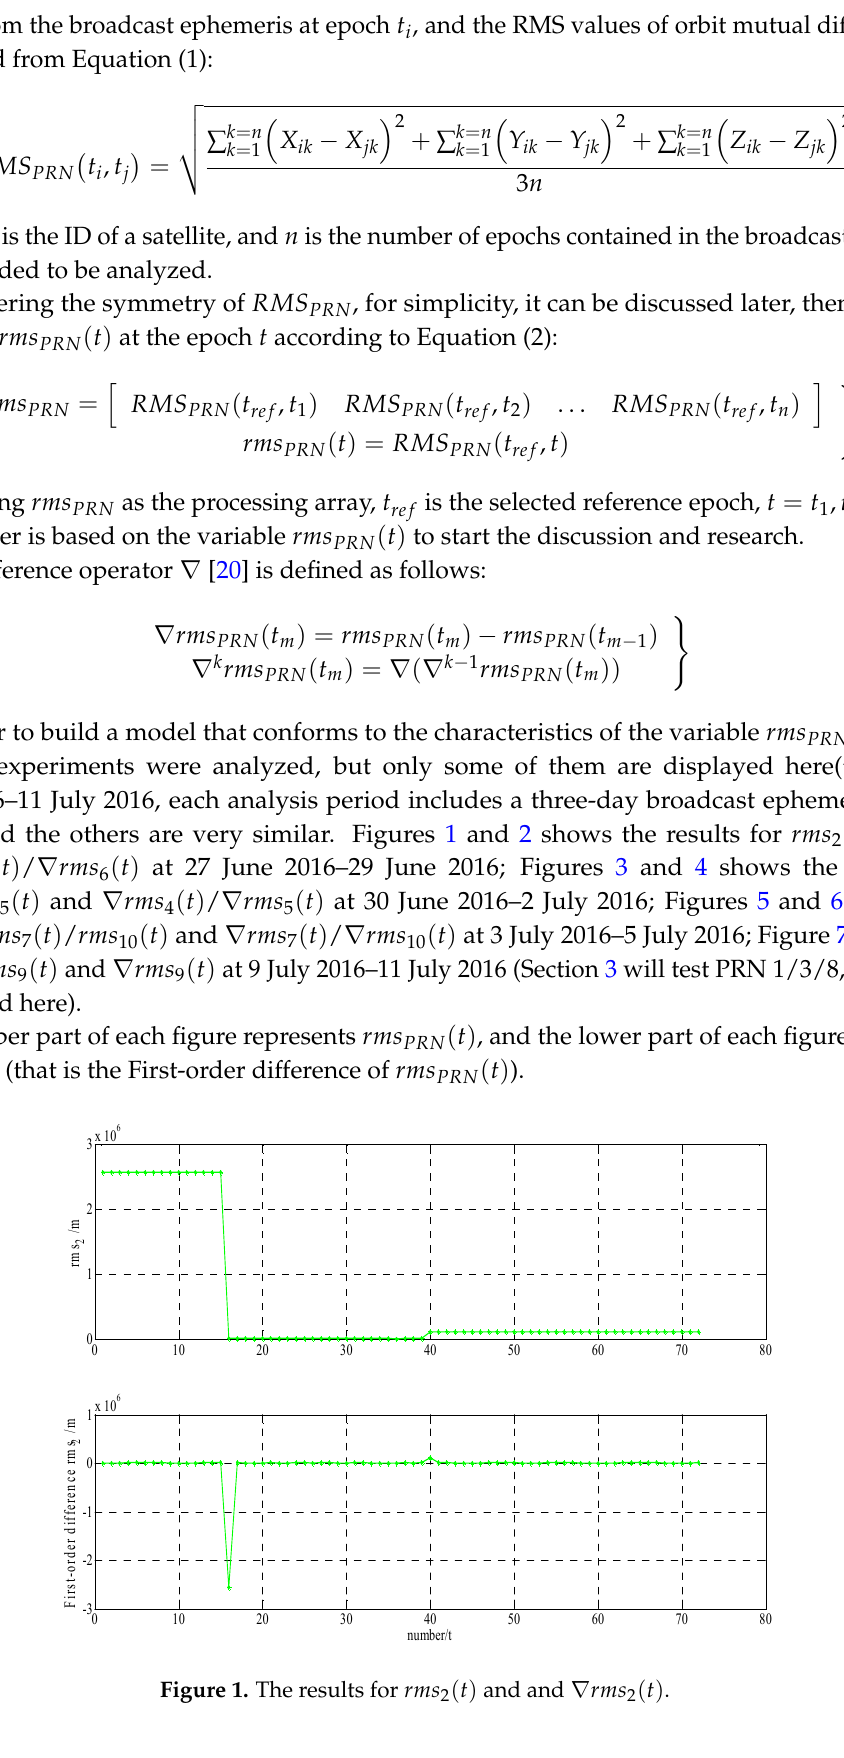
Figure 1. The results for